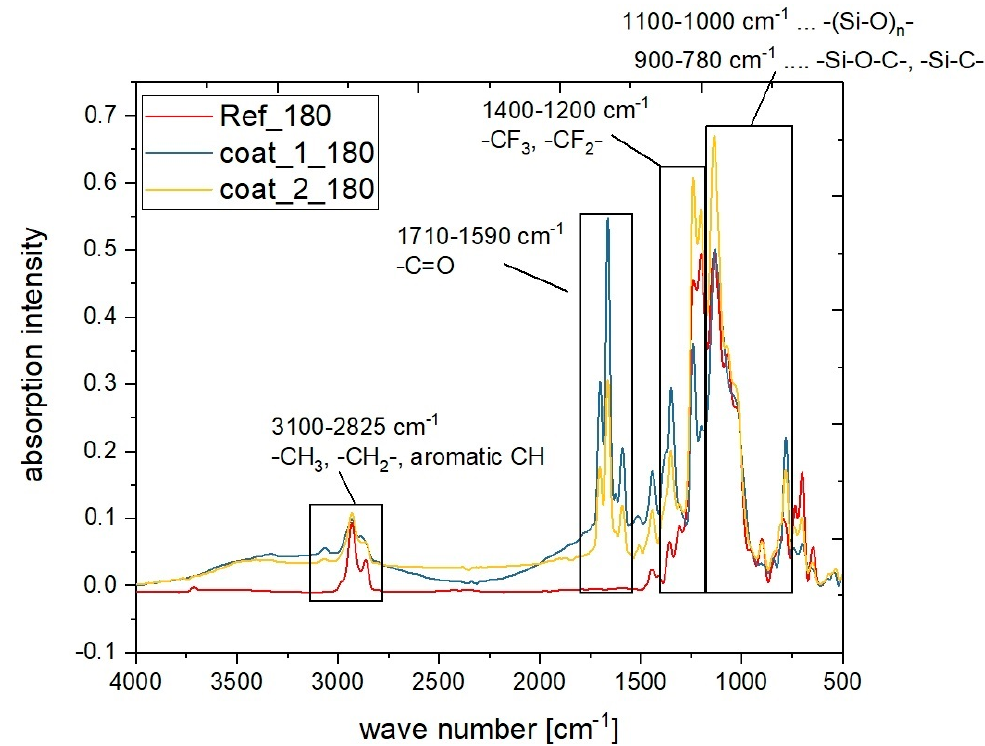
Figure 5. FTIR spectra of a reference coating (red) composed of PFOS and BOS (Ref_180), and representative coatings of coat_1 and coat_2 series composed of PFOS, BOS and NIPTES (coat_1_180 – blue, coat_2_180 - yellow).